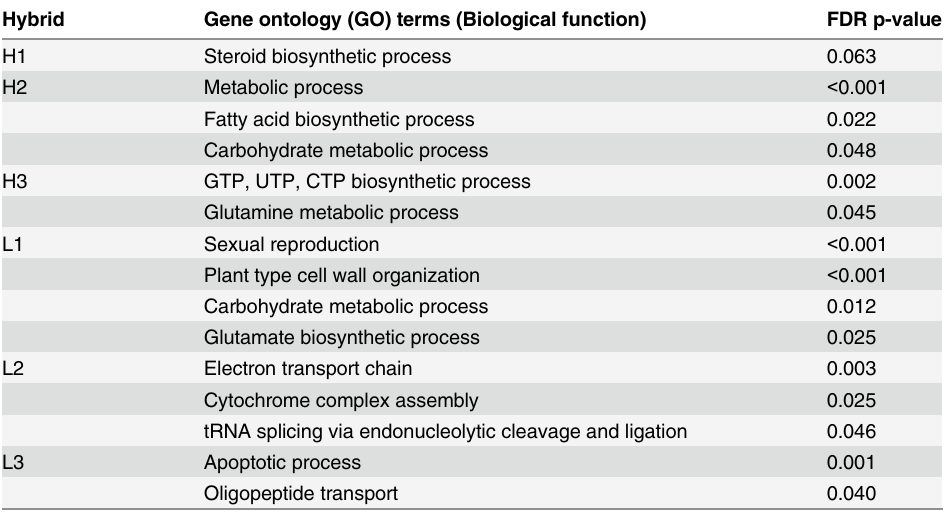
Table 4. Over-represented biological processes of common DEGs identified for each hybrid.